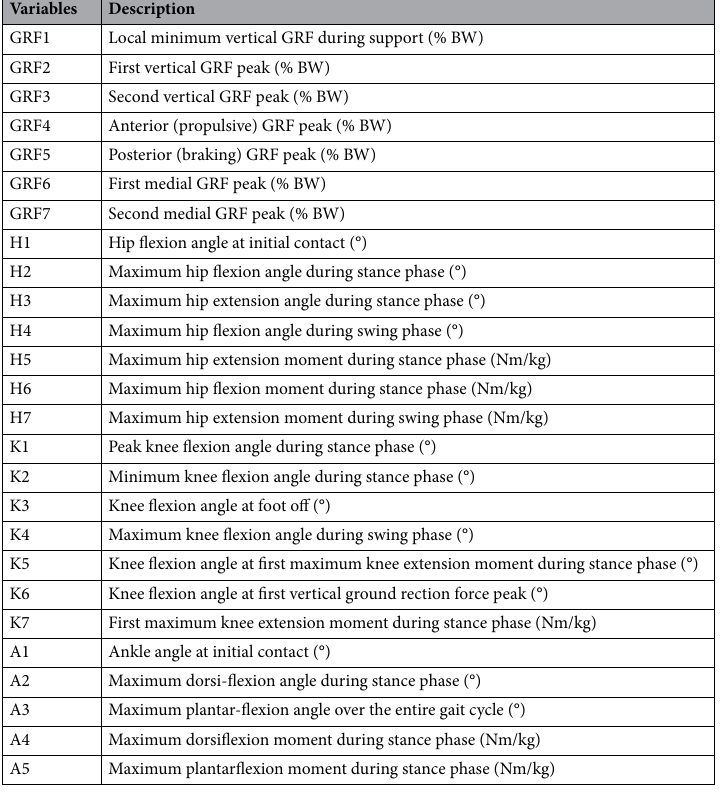
Table 5. Evaluated parameters of the gait cycle for vertical and horizontal GRFs and sagittal plane kinematics and